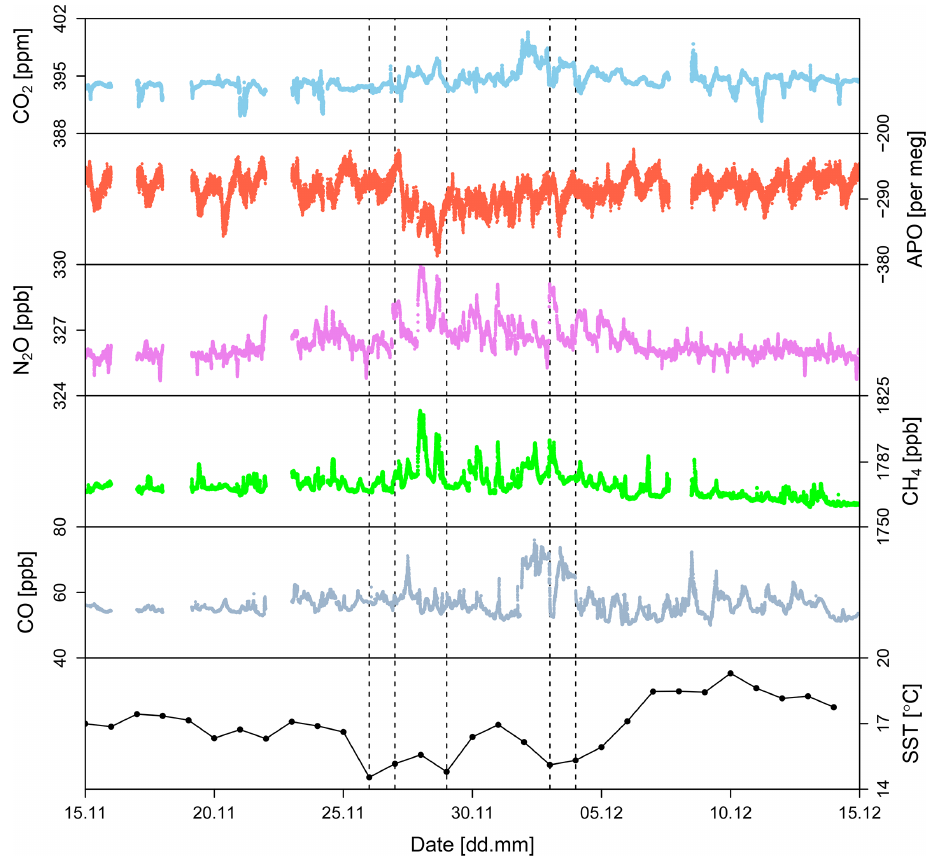
Figure 4. Atmospheric time series at NDAO throughout the upwelling event displayed in Fig. 1. Days flagged as upwelling events are shown as dashed vertical